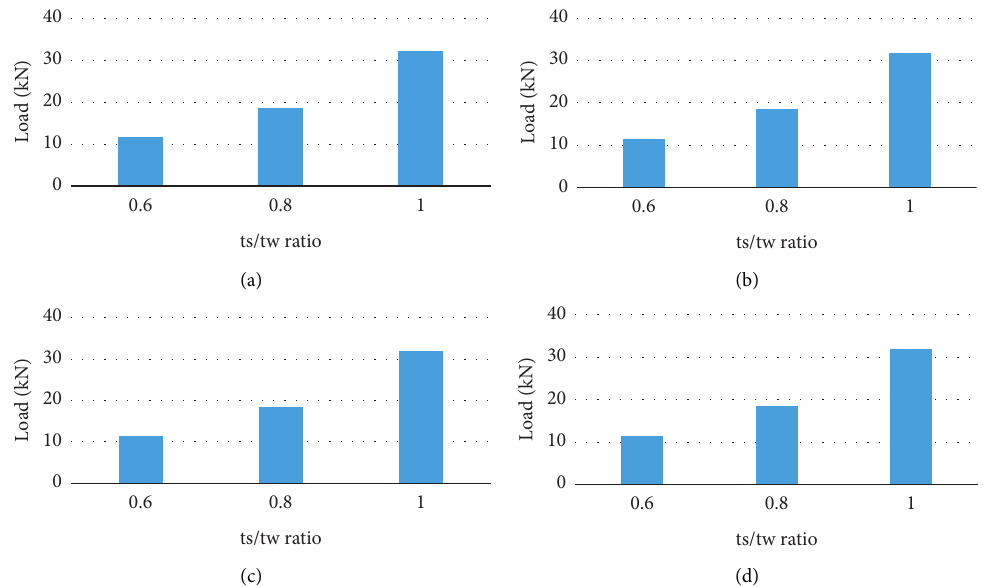
Figure 10: Effect of aspect ratio ( t and (d) 150 ° -type connection.